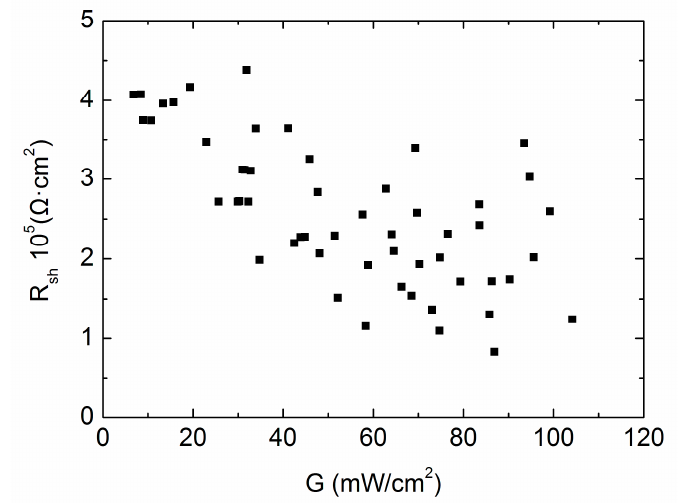
Figure 6. Shunt resistance R sh versus the illumination intensity G , including all 54 testing points.